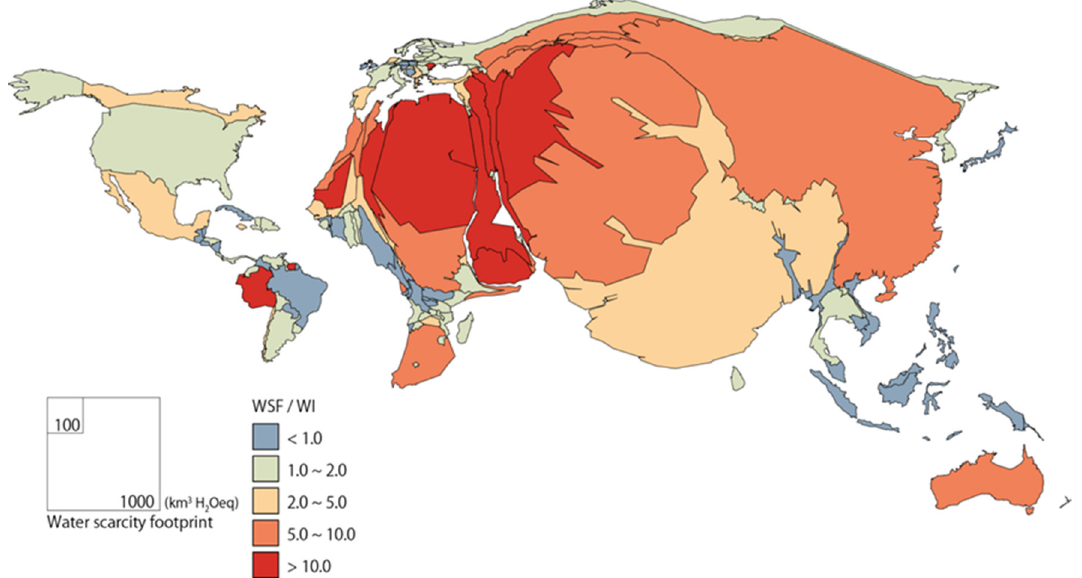
Figure 2. The water scarcity footprint for each country (area size) and the ratio of the water scarcity footprint to the water footprint inventory (colour coded).